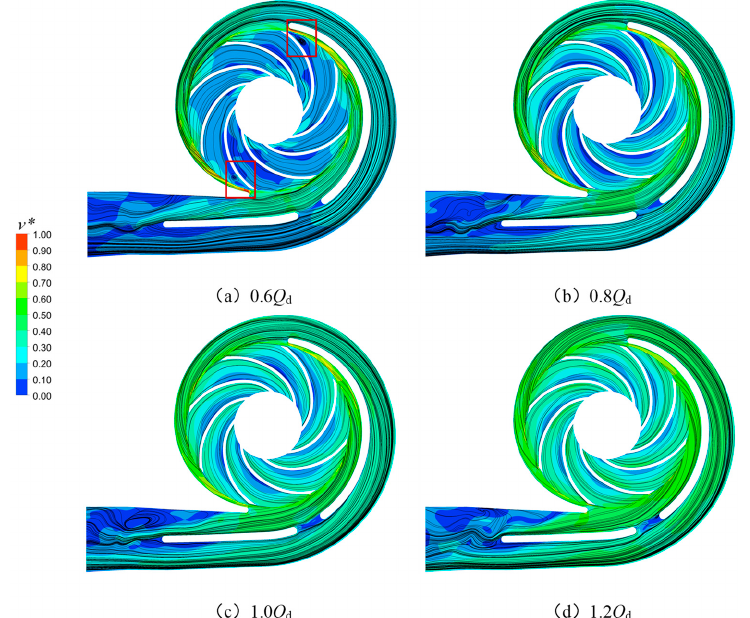
Figure 8. Velocity distribution of the second-stage impeller and volute under di ff erent fl ow rates.